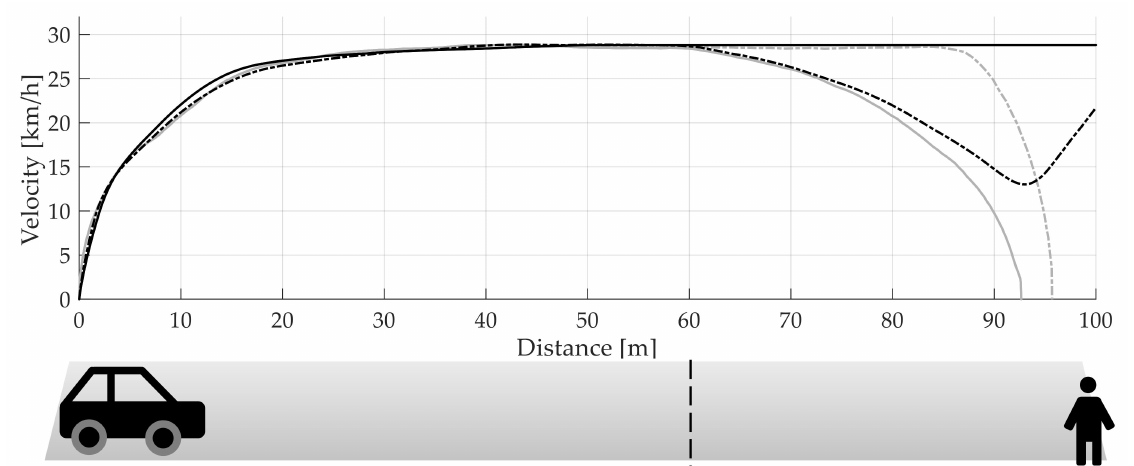
Figure 4. Unambiguous (solid lines) and ambiguous (dashed lines) target trajectory for the intentions Let the HRU go first (gray lines) and AV goes first (black lines). The vertical dashed line represents the position of the beginning of the time